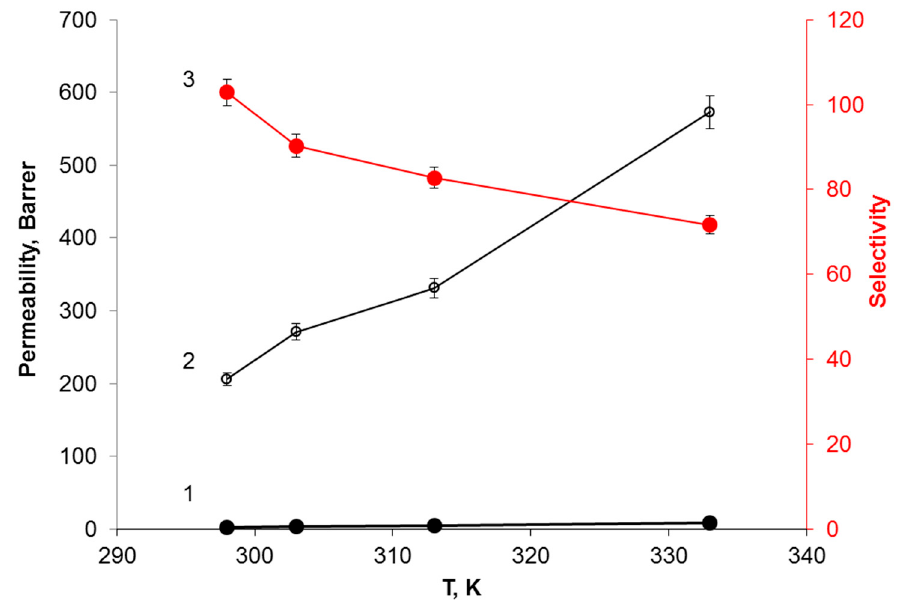
Figure 6. Effect of temperature on the permeability of CH 4 (1) and H 2 S (2) across MFFK-1 [bmim][ace] membrane and on the selectivity of H 2 S/CH 4 (3).